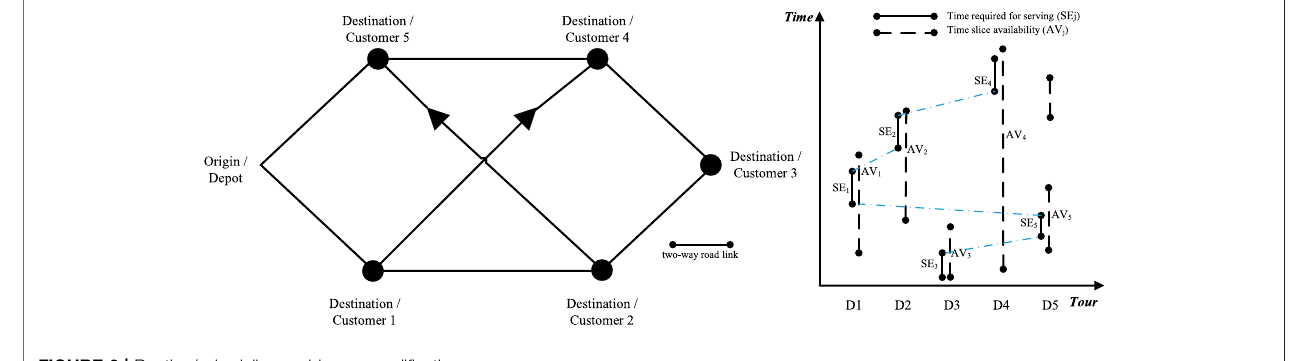
FIGURE 3 | Routing/scheduling problem exempli fi